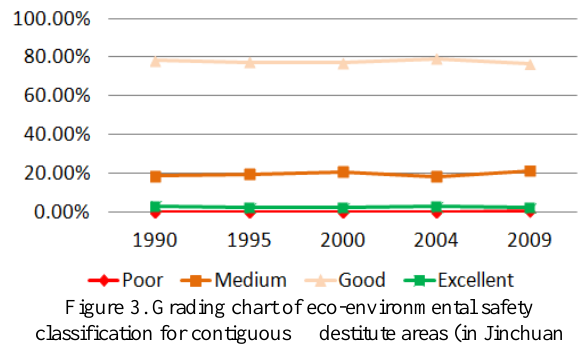
Figure 3. Grading chart of eco-environmental safety classification for